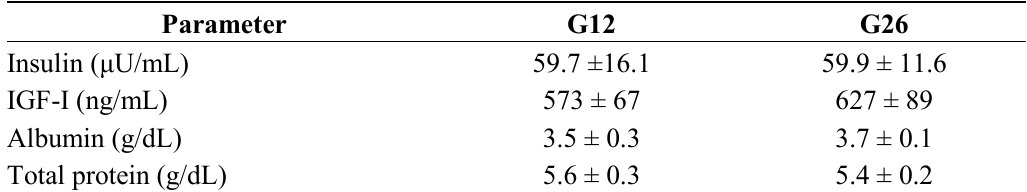
Table 3. Biochemical variables for plasma of experimental groups 1,2